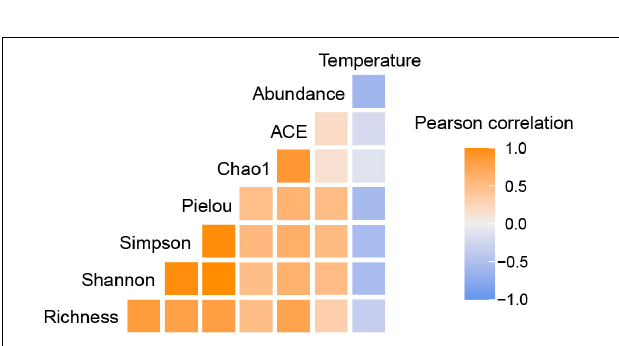
FIGURE 8 | The correlation between temperature and abundance/diversity of UCYN-A, revealed by Pearson correlation using the amplicon dataset and qPCR results. Six alpha-diversity indices were used to represent microbial